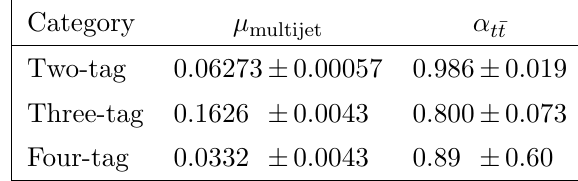
for the two-tag, three-tag and four-tag samples. The t (cid:22) t